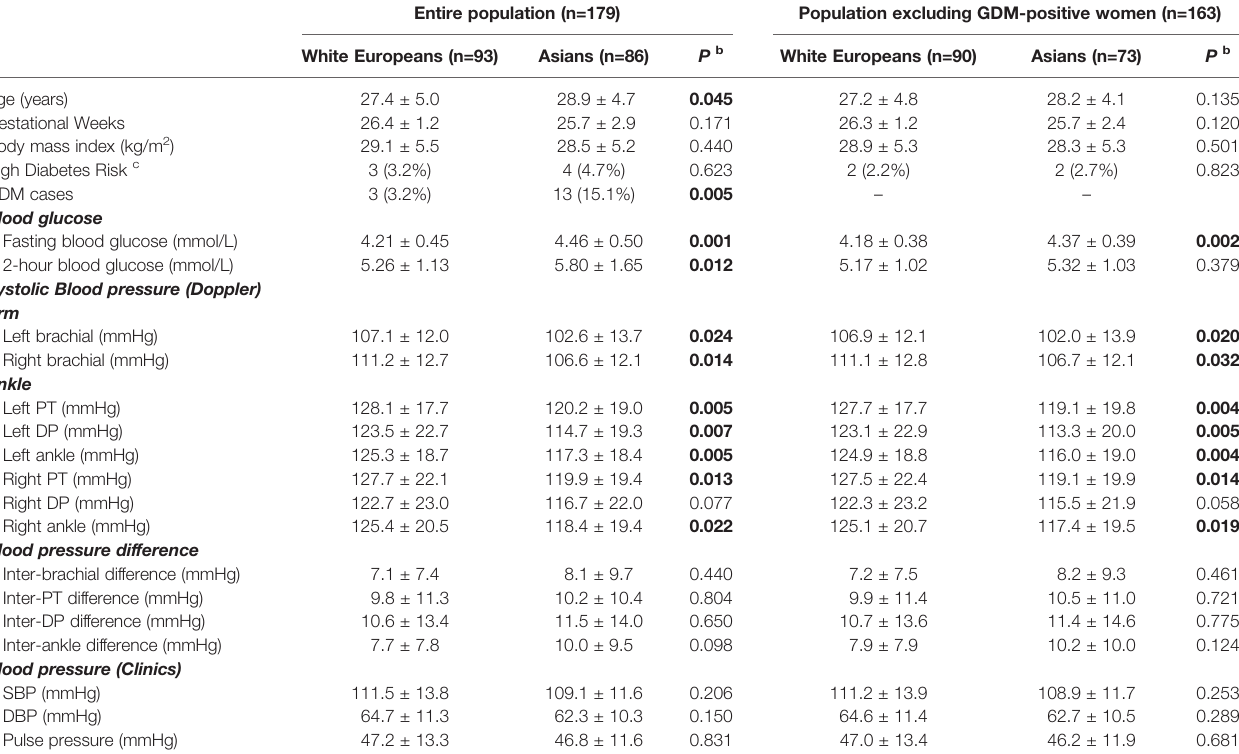
TABLE 1 | Characteristics of study participants a